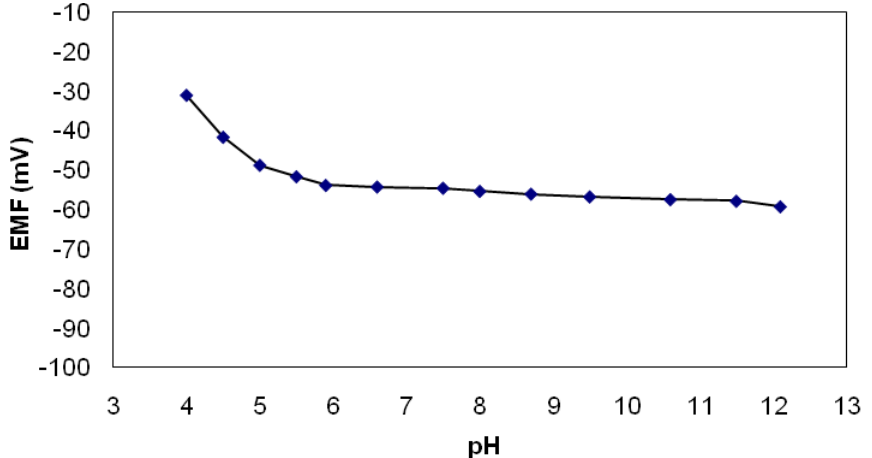
Figure 5. The pH influence on the potentiometric response.